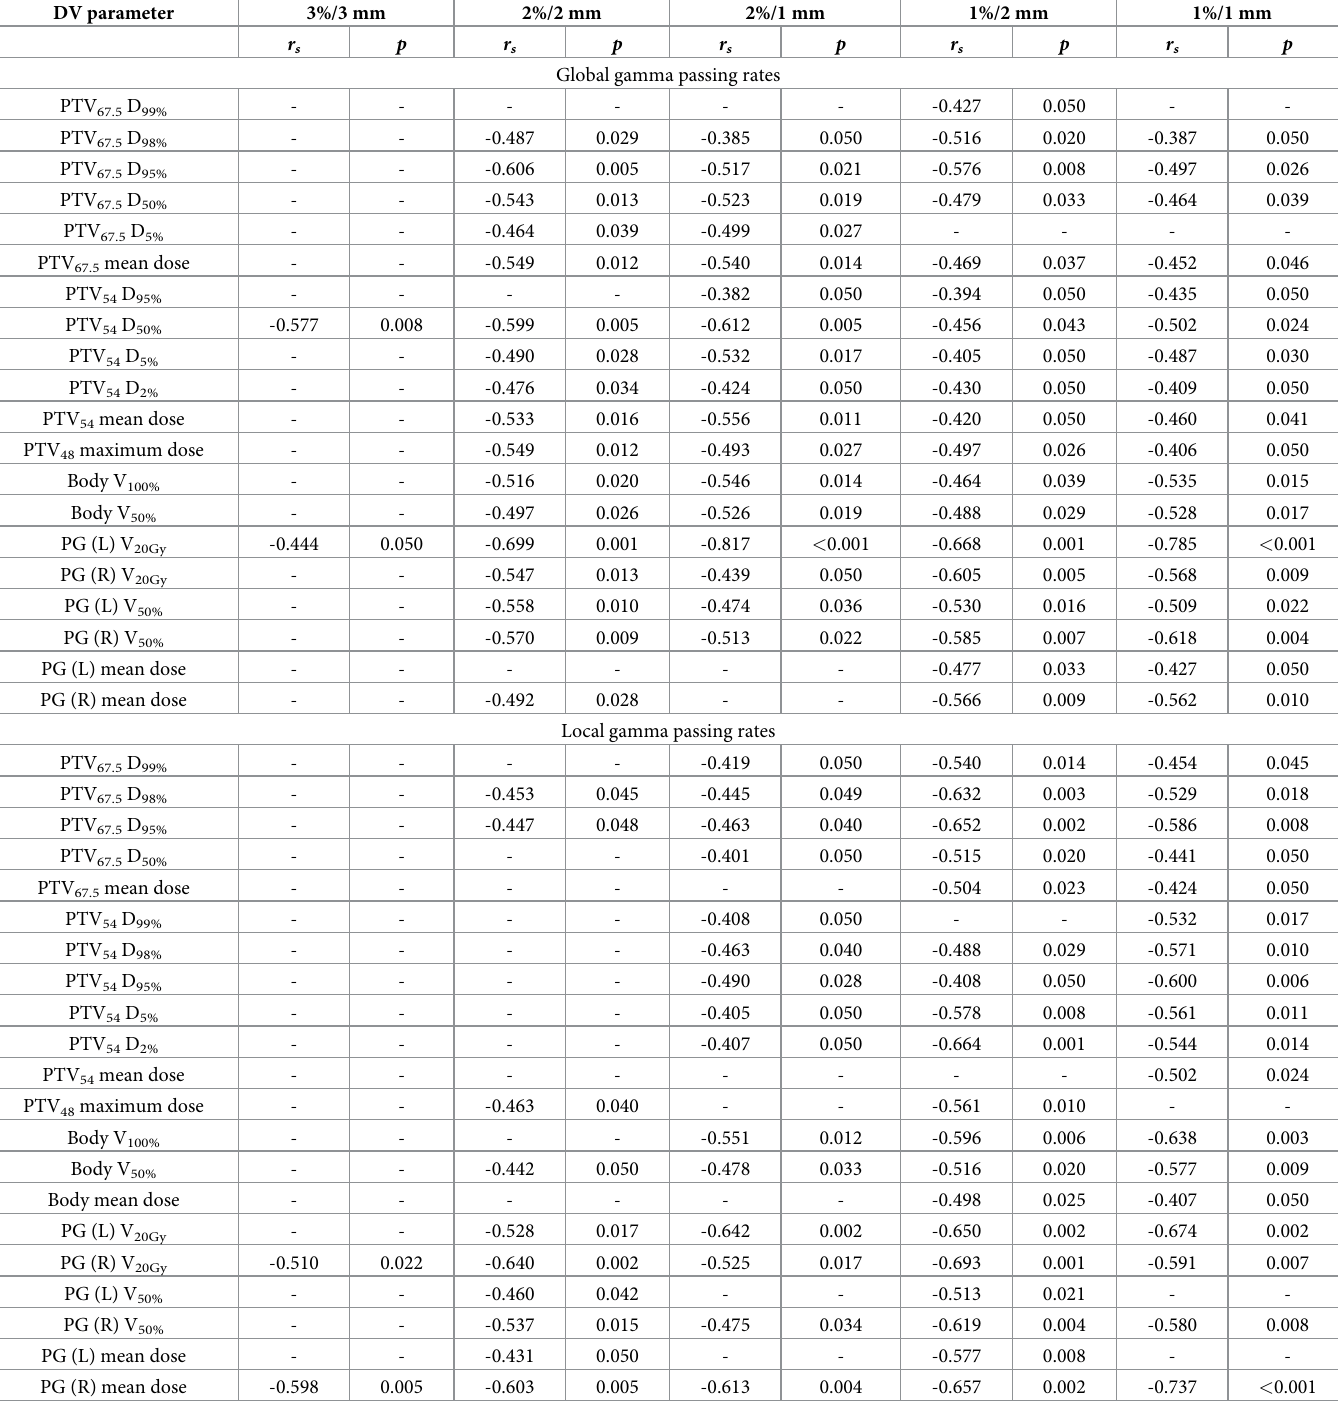
Table 4. Correlations of the gamma passing rates with the changes in the dose-volumetric parameters between the original VMAT plans and the plans recon- structed with the log files acquired during the VMAT deliveries of the TrueBeam